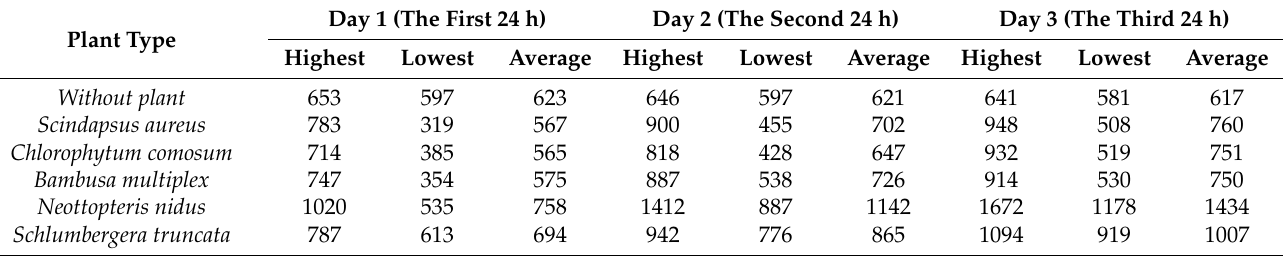
Table 3. Comparison of CO 2 concentration in sealed chambers in the poor lighting